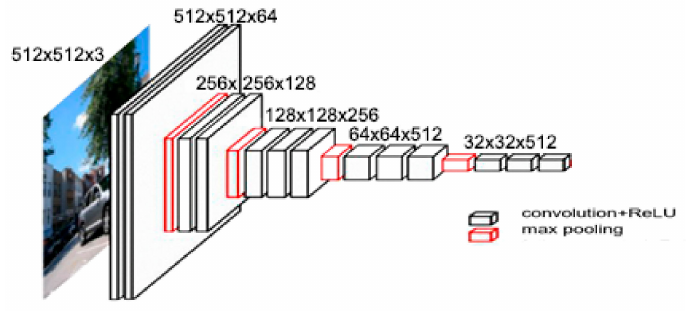
Figure 2. The structure of the feature extraction